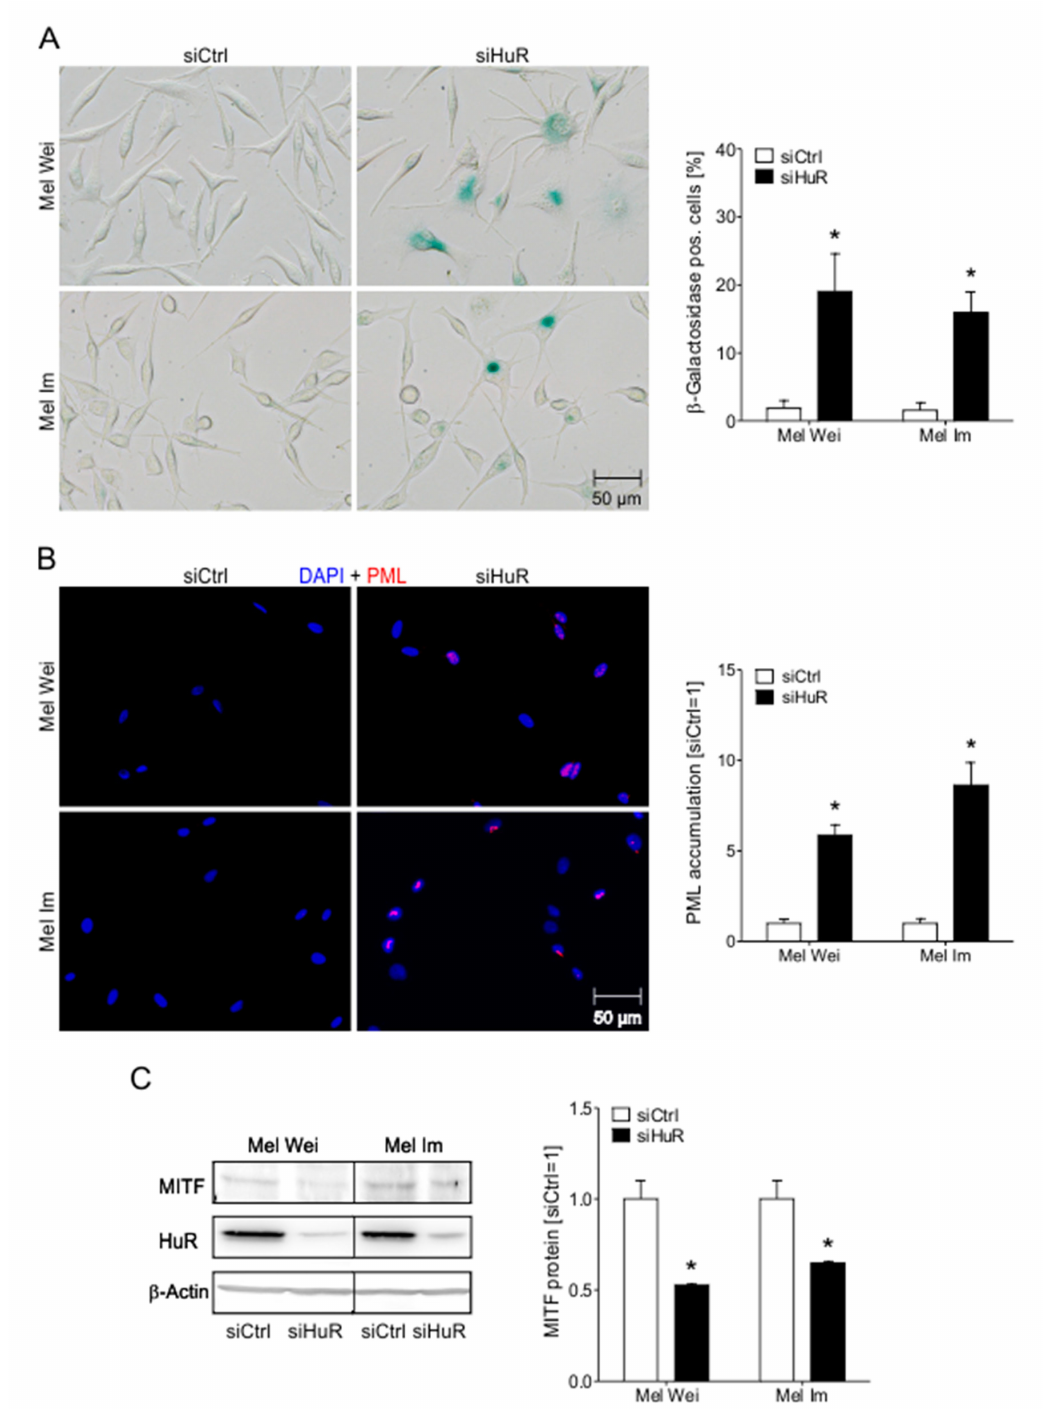
Figure5. InfluenceofaHuRknockdownonsenescencecharacteristicsinmelanomacells. ( A )Exemplary images of light microscopic examination of SA- β -galactosidase staining in Mel Wei and Mel Im cells (left). The percentages of SA- β -galactosidase positive cells (blue) were calculated (right) (siCtrl = 1). ( B ) Exemplary images of PML immunofluorescence staining of Mel Wei and Mel Im cell lines. Panels show overlays of PML (red) and DAPI (blue) staining (left). The graph shows the nuclear accumulation of PML (right) (siCtrl = 1). ( C ) Densitometric quantification (right) and exemplary image (left) of Western blot analysis of MITF protein levels in transfected Mel Wei and Mel Im cells (siCtrl = 1). *A p -value of < 0.05 was considered statistically significant. The uncropped blots and molecular weight markers of Figure 5C are shown in Figure